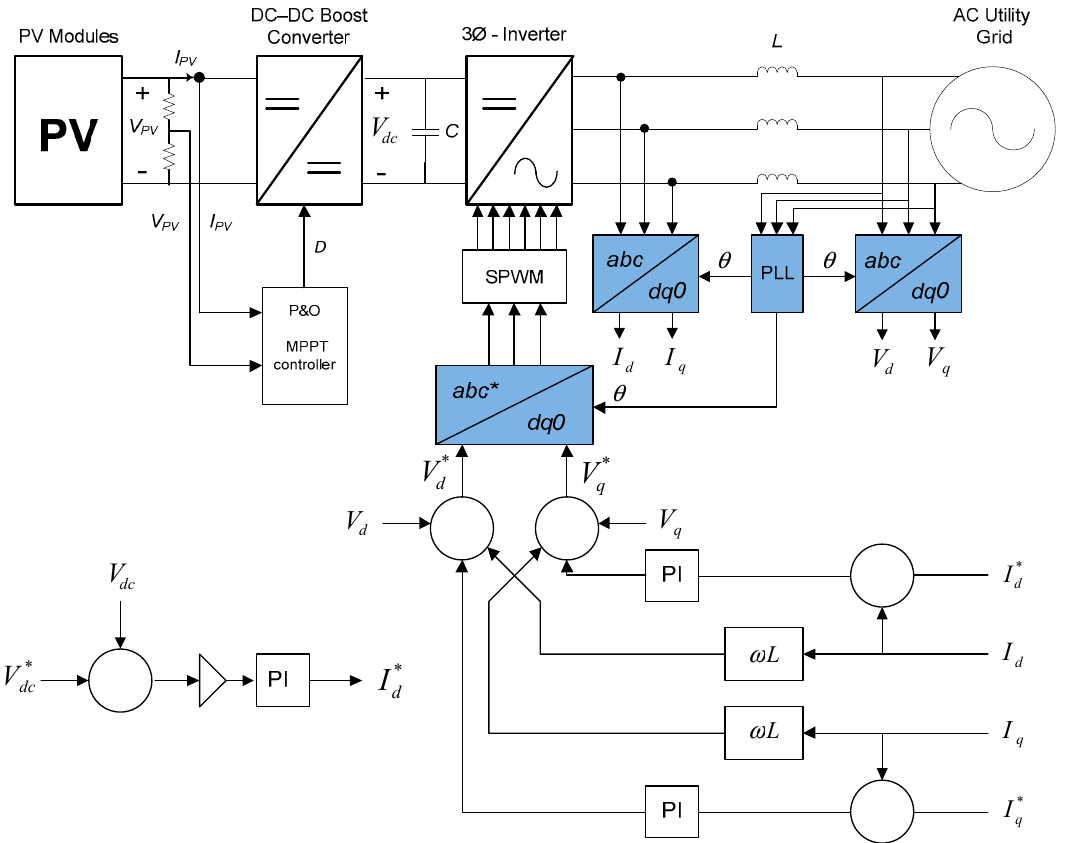
Figure 18. The general structure of the three-phase GPV generation system with transformation blocks.